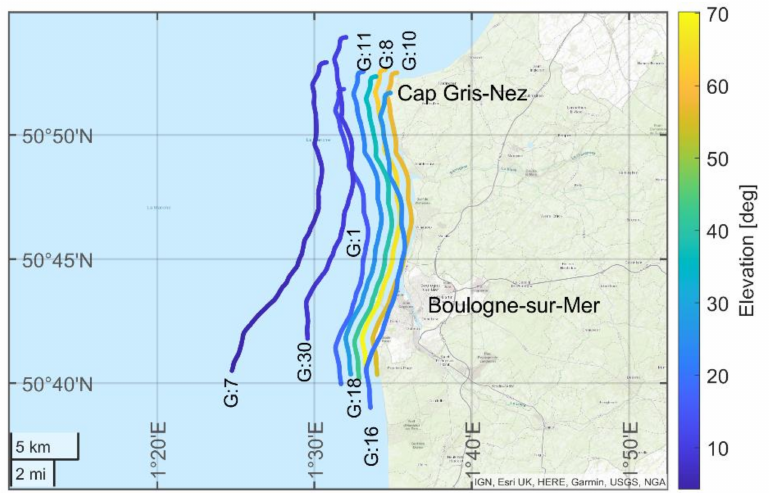
Figure 5. Specular point tracks for satellites 1, 7, 8, 10, 11, 16, 18, and 30 in the north-to-south segment from Cap Gris-Nez and Boulogne-sur-Mer on 17